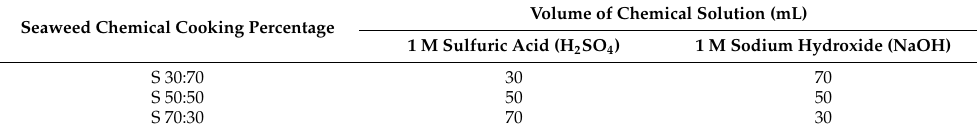
Table 1. Volume (mL) of mixed chemical solution for different chemical cooking percentages. Seaweed Chemical Cooking Percentage